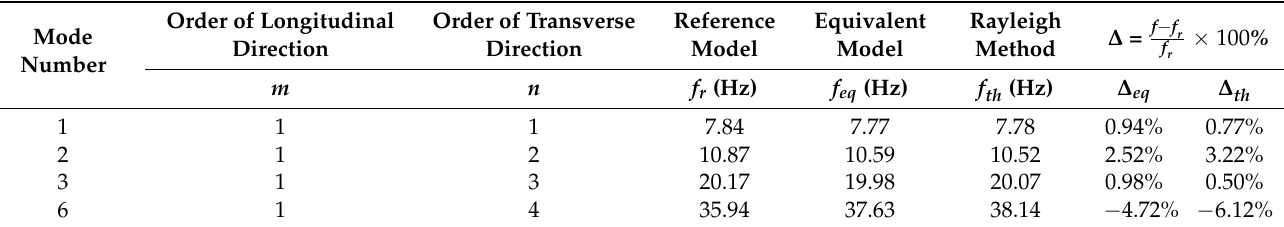
Table 1. The calculation frequencies and error of the three